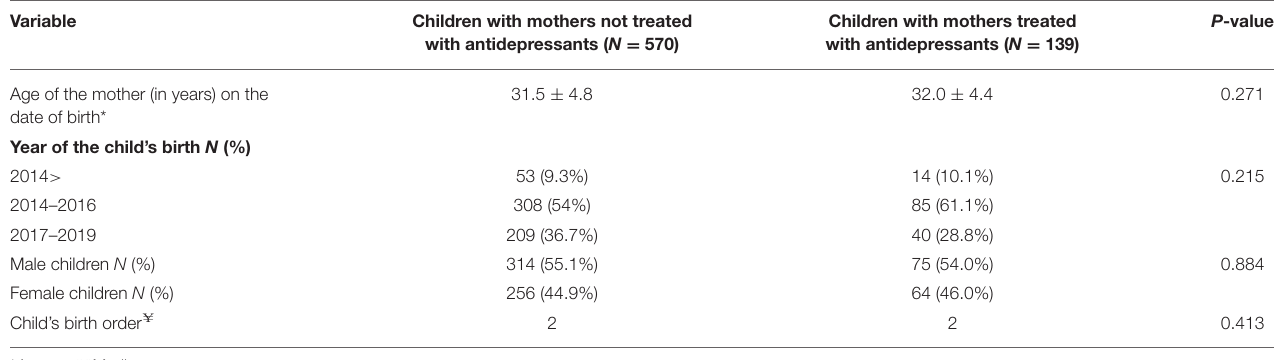
Age of the mother (in years) on the date of birth*